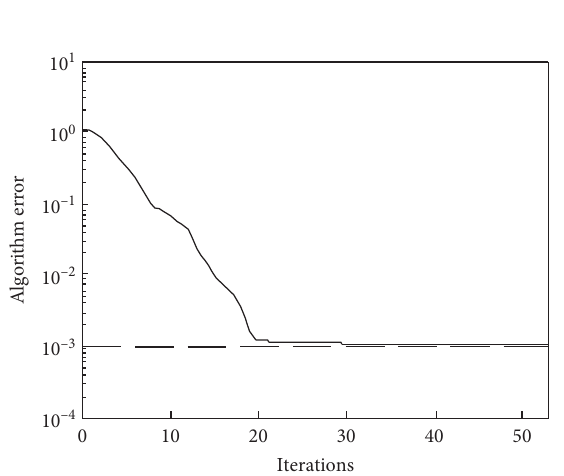
Figure 3: Standard BP neural network training process without PCA.